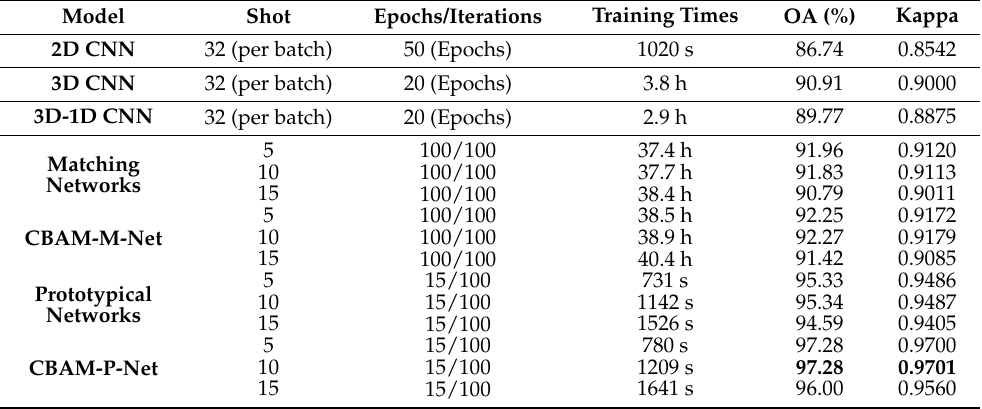
Comparison of classification accuracy between matching networks and prototypi- cal